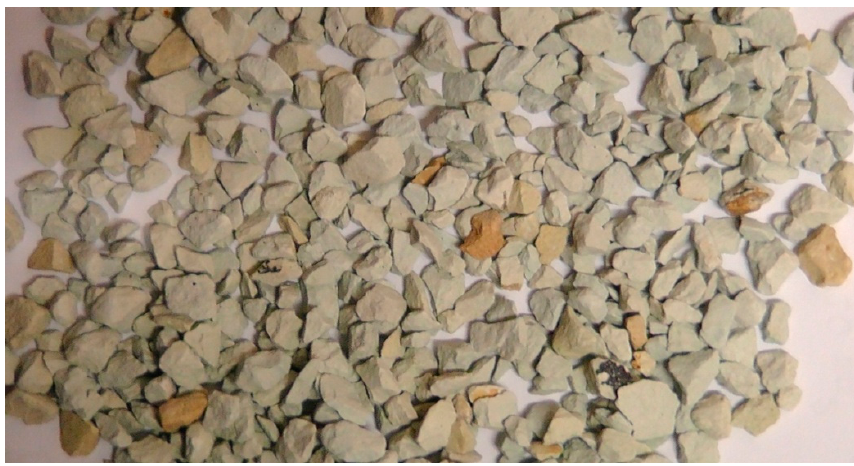
Figure 1. Zeolite clinoptilolite with a grain size from 2.5 to 5 mm.